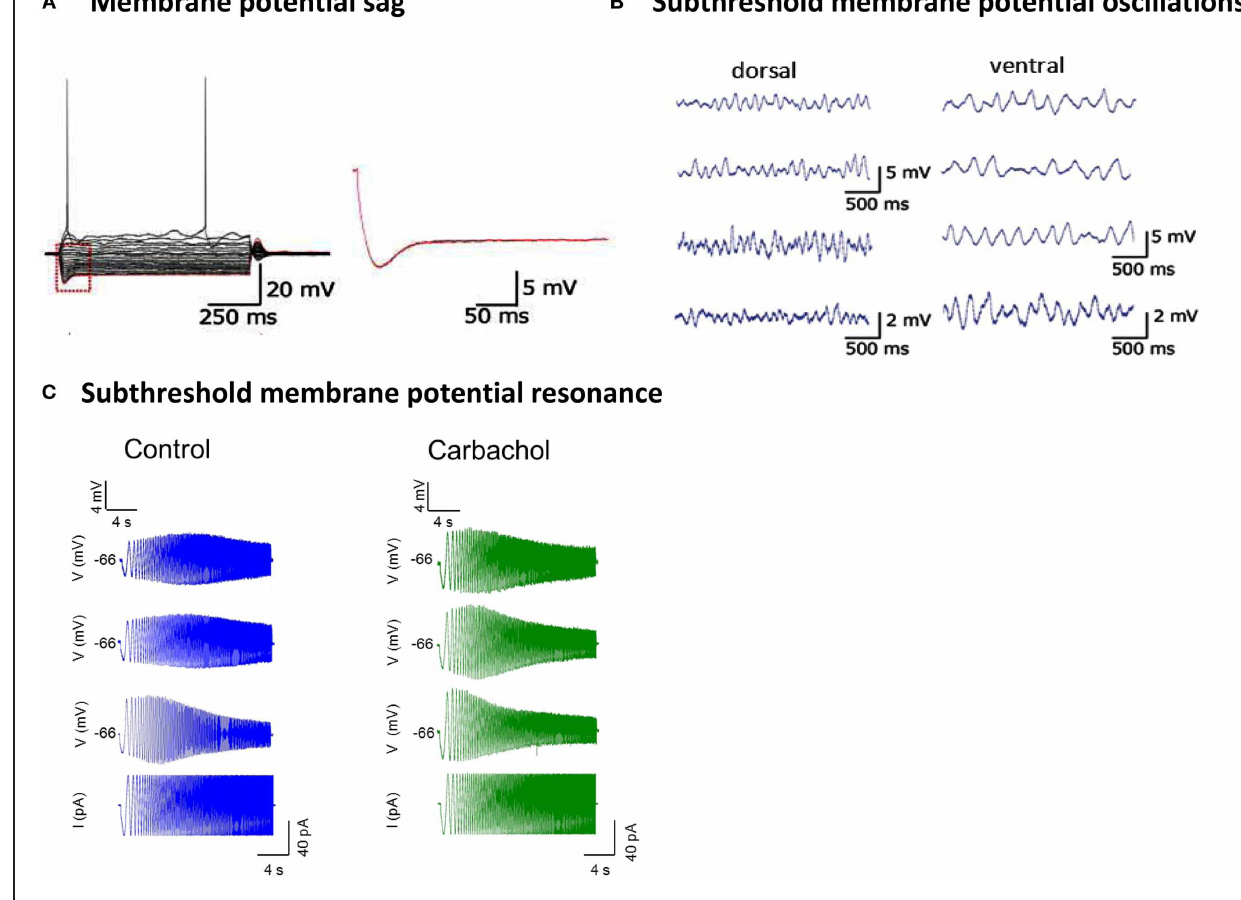
FIGURE 2 | Subthreshold electrophysiological properties of stellate cells in medial entorhinal cortex. (A) Whole cell patch clamp recordings demonstrate that hyperpolarizing current injections from a membrane potential of approximately − 60mV produces membrane potential sag in SCs. Inset: the sag amplitude is measured as the difference between the hyperpolarized membrane potential and the steady state membrane potential. (B) Subthreshold membrane potential oscillations recorded in dorsal stellate cells (left) and ventral stellate cells (right) at average